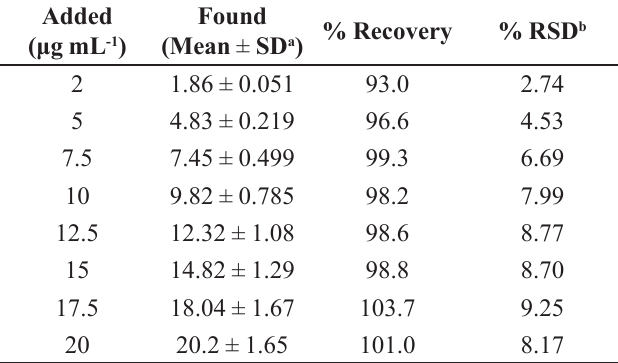
TABLE III - Recovery of diclofenac in human